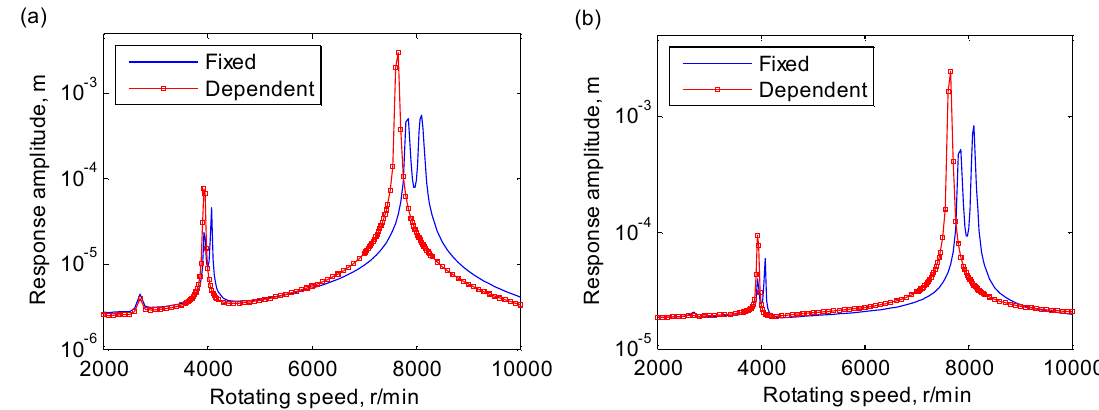
Figure 10. The response amplitudes of the central node of the cracked anisotropic rotor-bearing system with fixed and speed-dependent coefficients: ( a ) along the horizontal direction; ( b ) along the vertical direction. The parameter α k of both cases equals 1.0, and the parameter β k of the fixed case is 0.2.